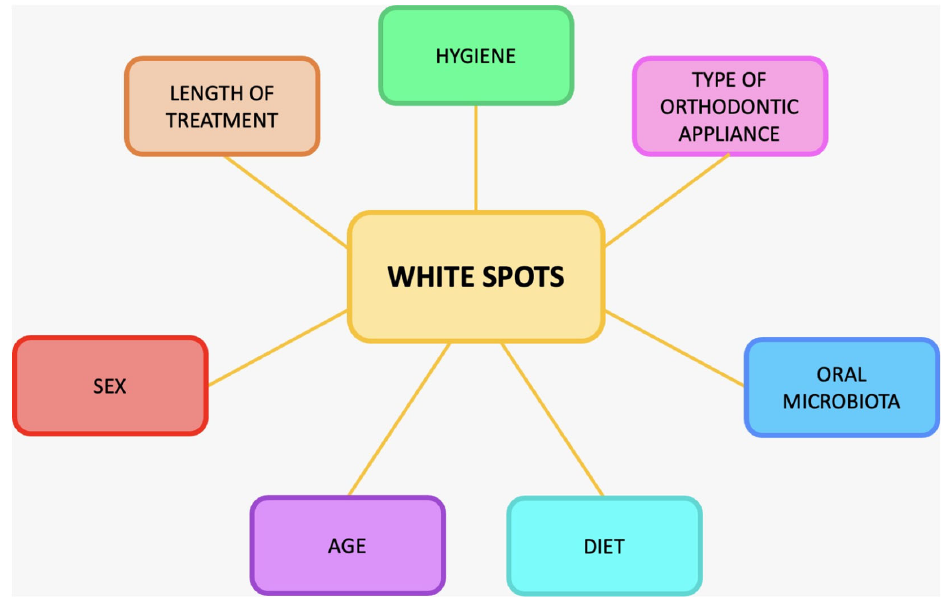
Figure 1. Causes of white spots.